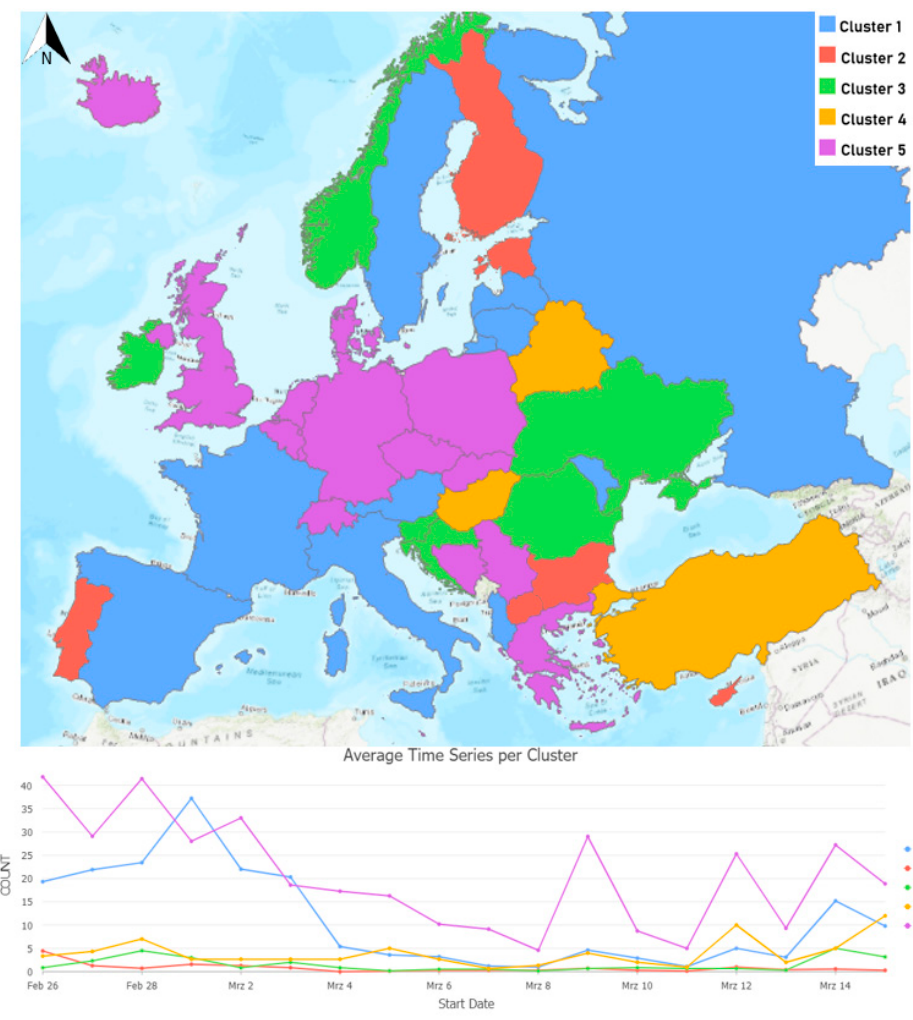
Figure 6. Spatiotemporal tweeting behavior clusters (map and a graph representing average counts)—RQ3a. Table 1. Details of the clusters—RQ1b (countries with the most tweets in each cluster are written in bold). Peak Number Cluster Countries (Average Count of Per Cluster) Tweets